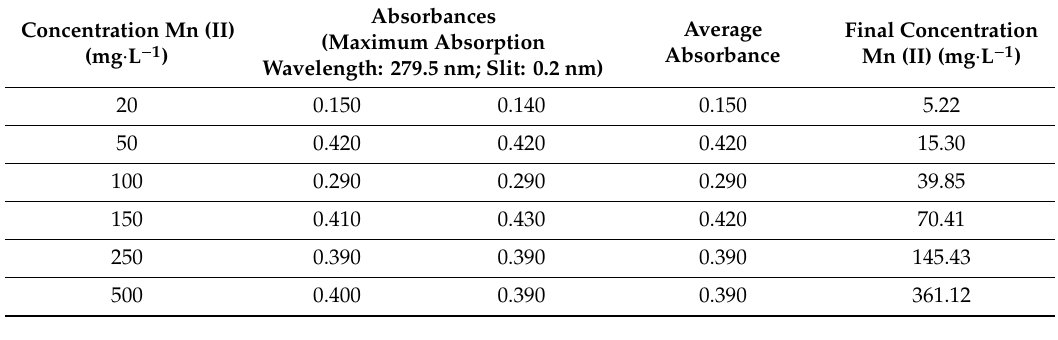
Table 4. Experimental results of Langmuir Isotherm with CP.